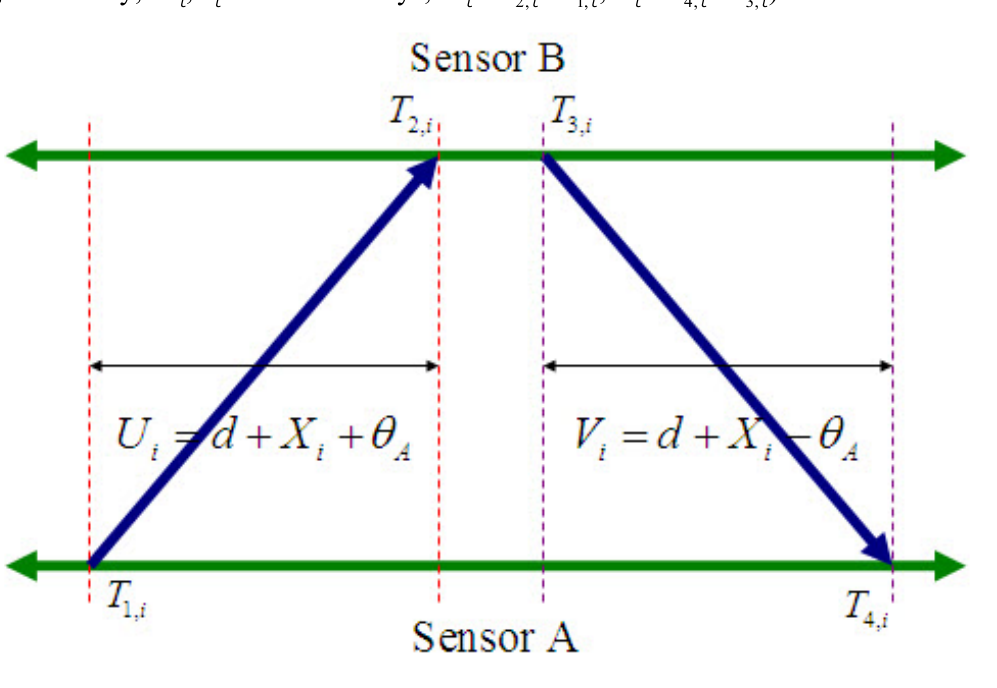
Figure 5. Two-way message exchange model with clock offset ( propagation